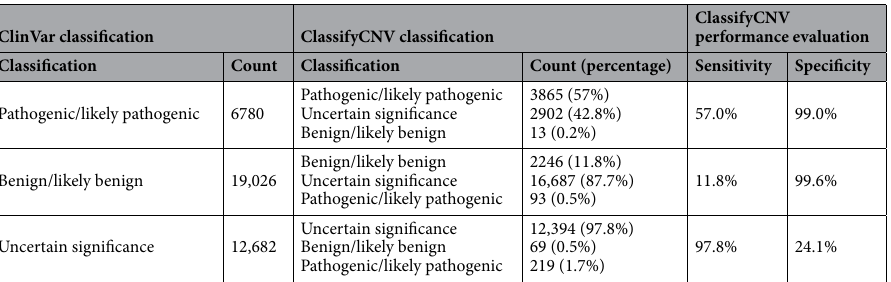
Table 1. ClassifyCNV performance on ClinVar data. The pathogenic/likely pathogenic variants and variants of uncertain significance show a high degree of concordance between the original ClinVar classification and the ClassifyCNV result. The majority of benign variants were classified as variants of uncertain significance.